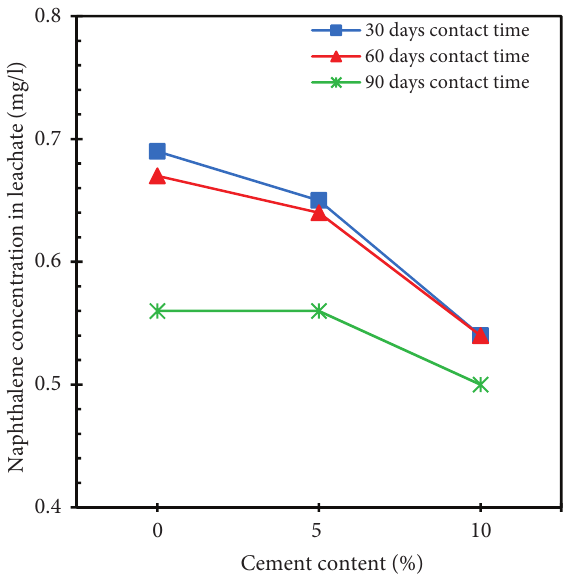
Figure 6. Leachate naphthalene concentration